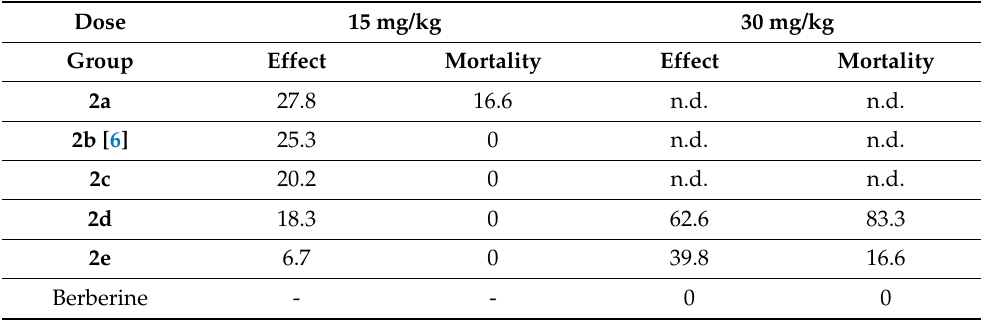
Table 2. OGTT screening results. The data are presented as the difference in AUC of the compounds compared to the AUC of the control in each individual experiment in %.